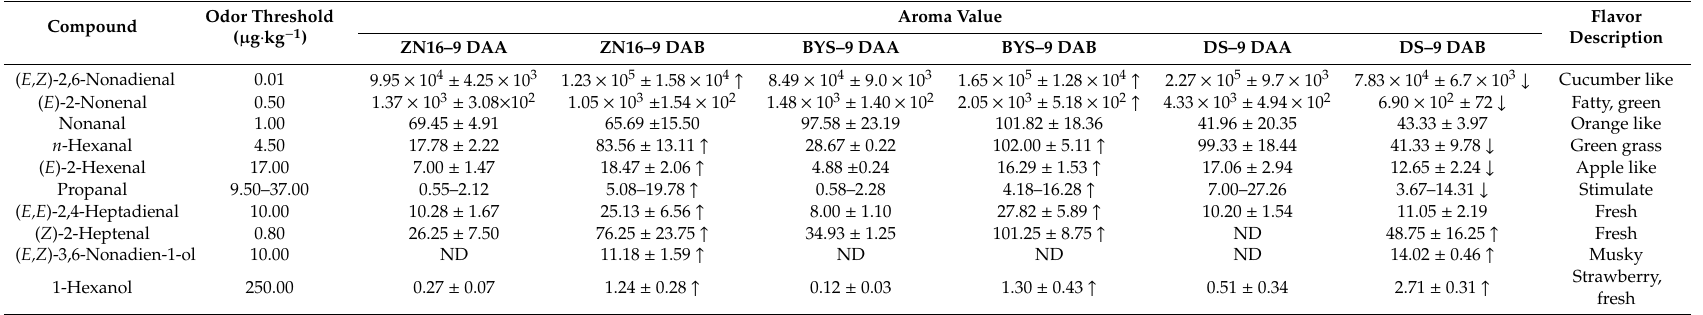
Table 1. Odor thresholds and aroma values of di ff erent cucumber